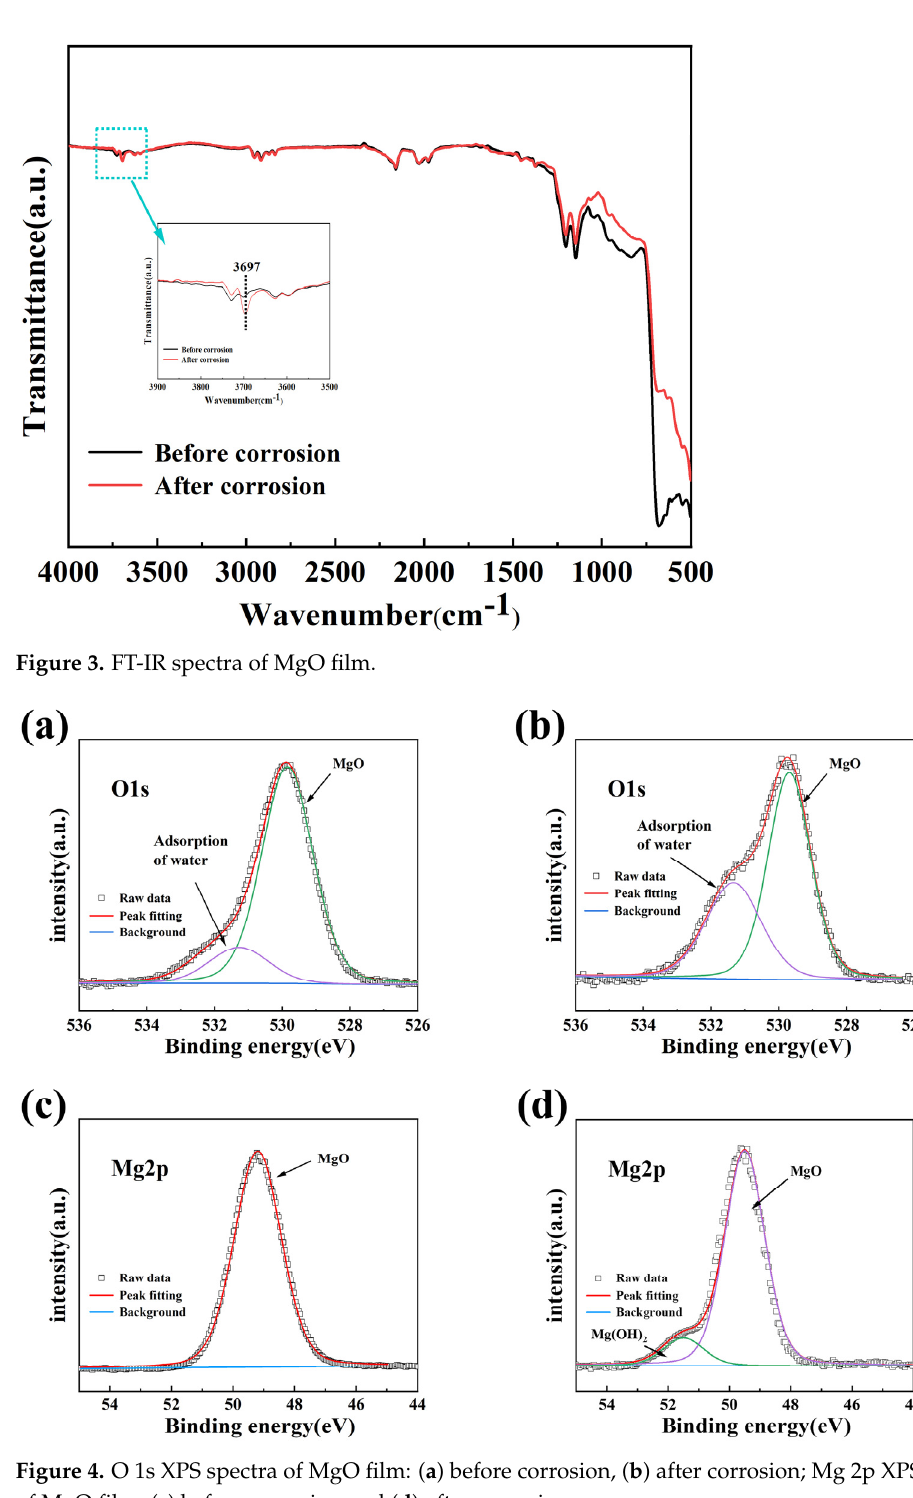
Figure 4. O 1s XPS spectra of MgO film: ( a ) before corrosion, ( b ) after corrosion; Mg 2p XPS spectra of MgO film: ( c ) before corrosion and ( d ) after corrosion.